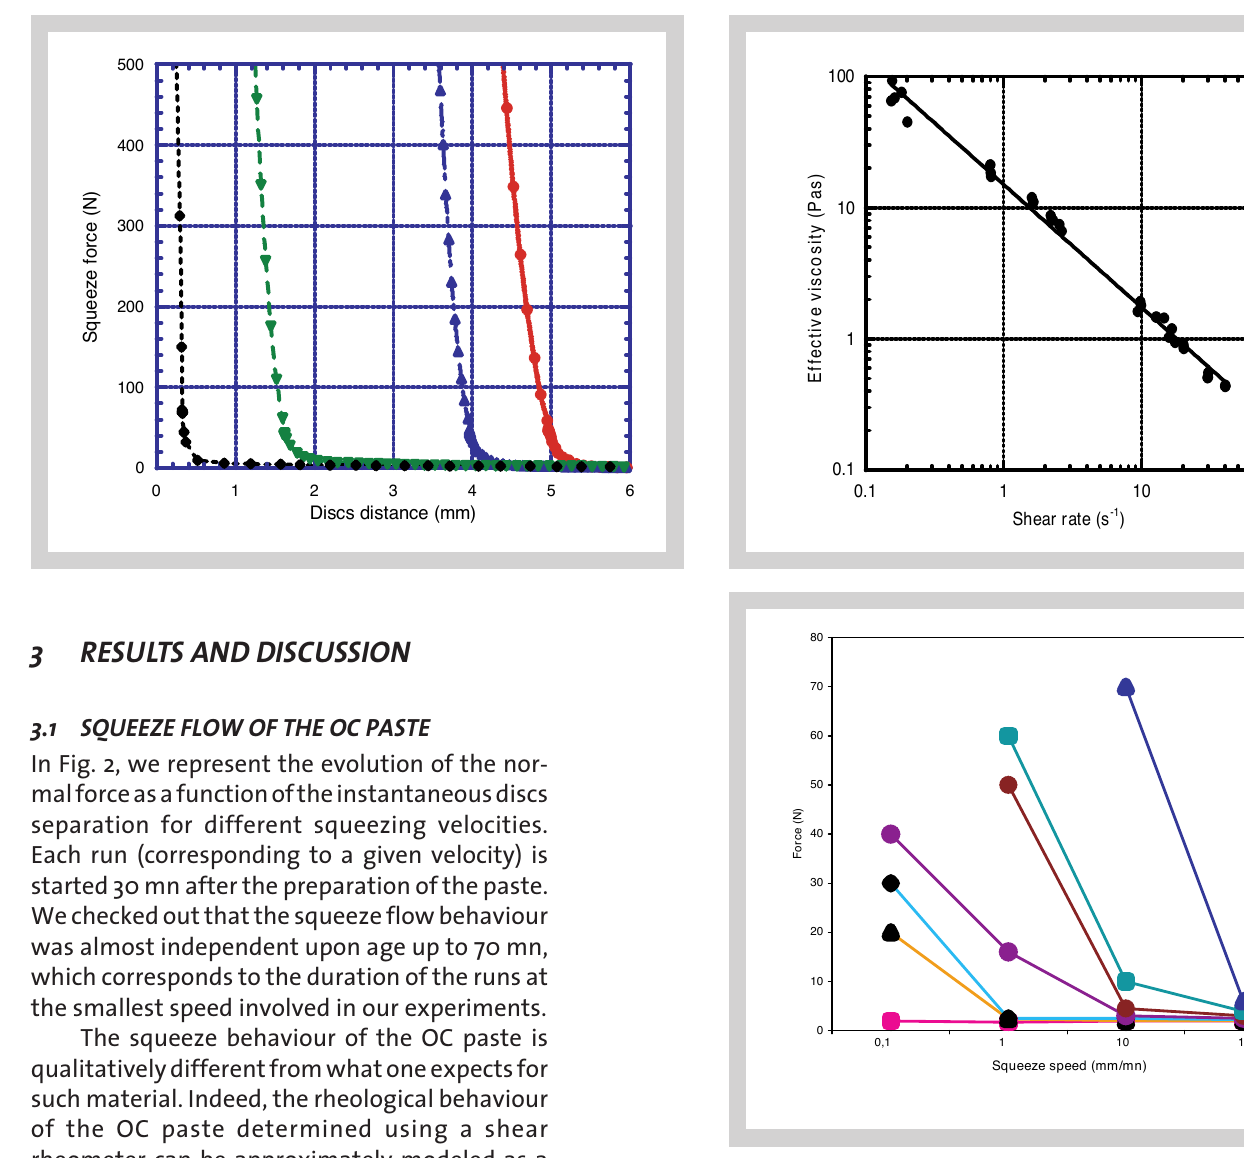
Figure 2 (left above): Evolution of the squeeze force F as a function of discs separation h for different velocities U for an OC paste: Ï 100 mm/mn; Ù 10 mm/mn; Ú 1 mm/mn; Ê 0.1 mm/mn. Figure 3 (right above): Rheological behaviour of the OC paste as determined using a shear-rheometer with a Couette geometry: Ê Experimental data and - Power law fit. Figure 4 (right below): Evolution of the squeeze force as a function of speed for different instantaneous discs separations h for the case of an OC paste: · 5.4 mm; Û 5.16 mm; Ì 5 mm; Á 4 mm; Ê 3 mm; ‡ 2 mm; Ú 1